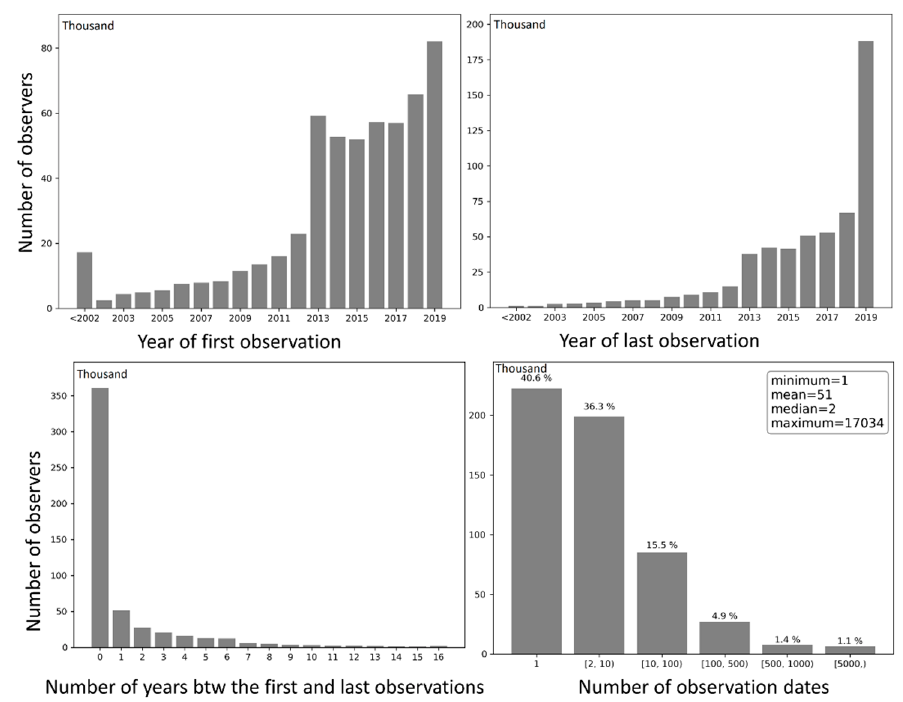
Figure 13. Frequency distribution of observers by year of first observation ( upper left ), year of last observation ( upper right ), number of years between the first and last observations ( lower left ), and number of active dates ( lower right ).